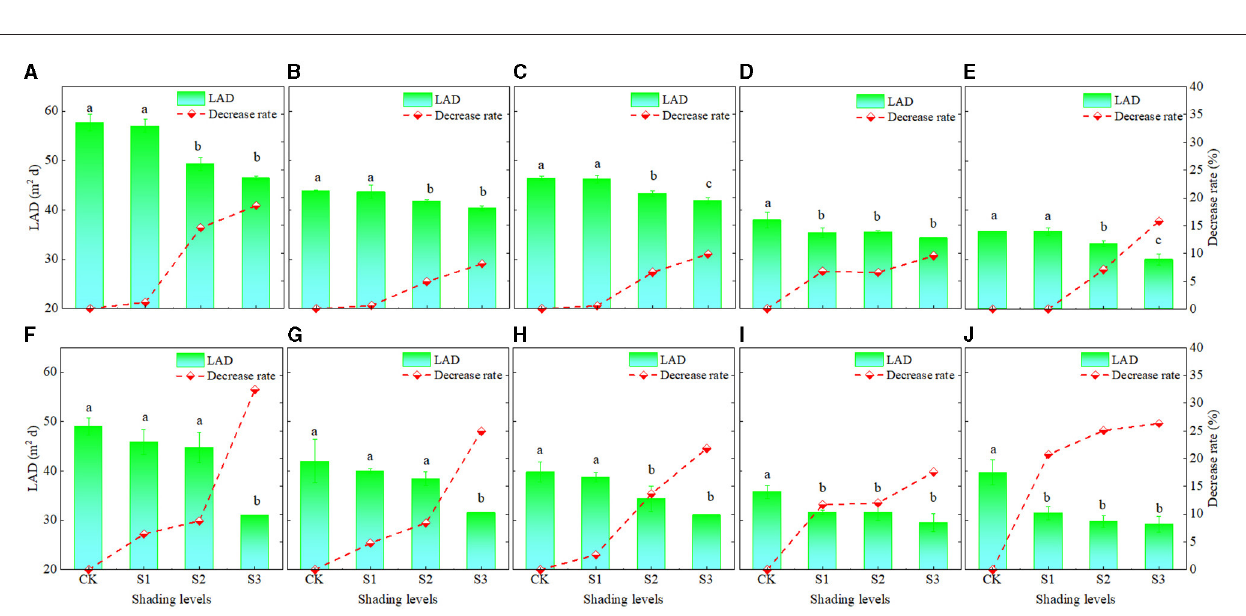
FIGURE 3 | Ear leaf photosynthetic rate ( Pn ) at the grain-filling stage of maize cultivars XY335 and ZD958 under low-light stress in 2018. See Figure 1 for planting density and shading treatment definitions. Different lowercase letters of the same cultivar above the columns show significant differences between each shading treatment for each planting density at P < 0.05.